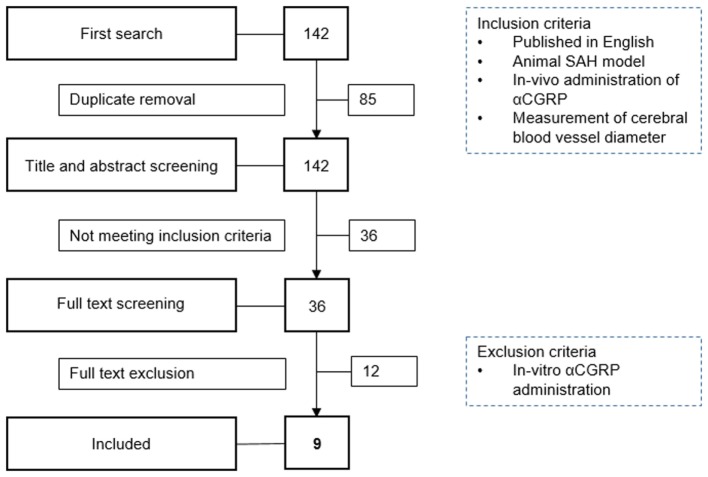
Flowchart of study selection. SAH, subarachnoid hemorrhage; αCGRP, alpha calcitonin gene-related peptide.